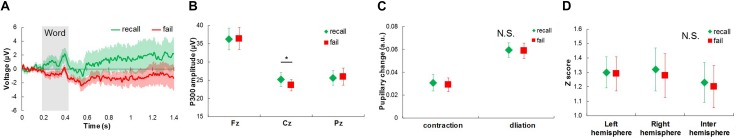
Physiological responses extracted from EEG and pupil diameter signals between recalled words and failed words in short time-scale comparison. (A) Average response waveforms of EEG signals for Cz channel for recall words (recall) and fail words (fail). Gray rectangle represents duration of word presentation. (B) Comparison of P300 amplitude between recall and fail words. (C) Comparison of pupillary contraction and dilation between recall and fail words. (D) Comparison of functional connectivity between recall and fail words. Bars represent standard errors. N.S., not significant. ∗p < 0.05.